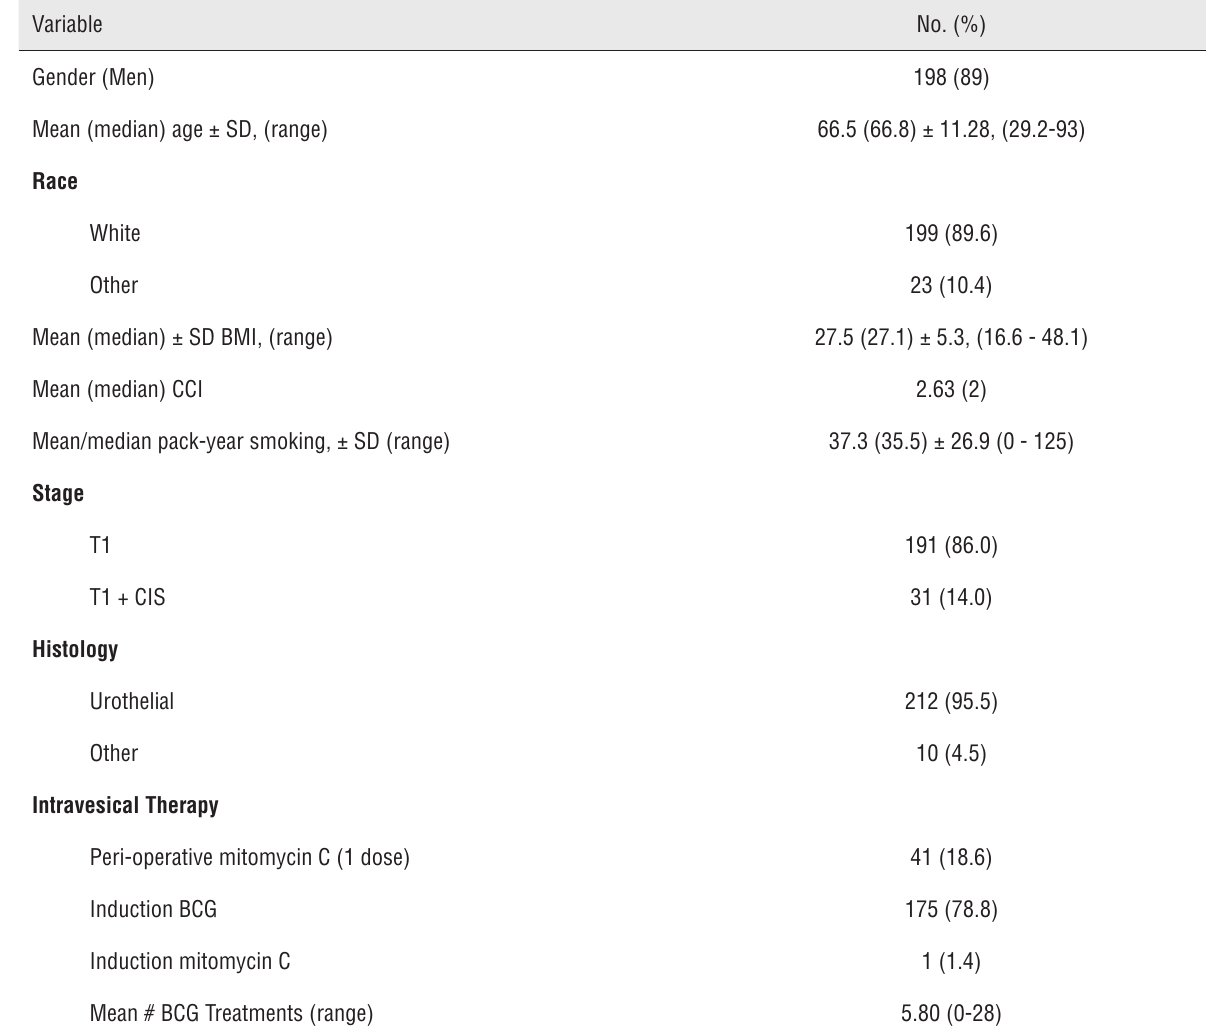
Table 1 - Clinical and Demographic Characteristics at Presentation of Patients with High-Grade T1 Bladder